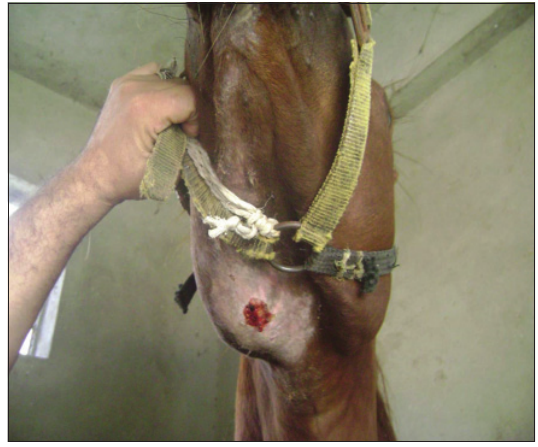
Figure-5: Strangled Arabian horse showing submaxillary lymph node